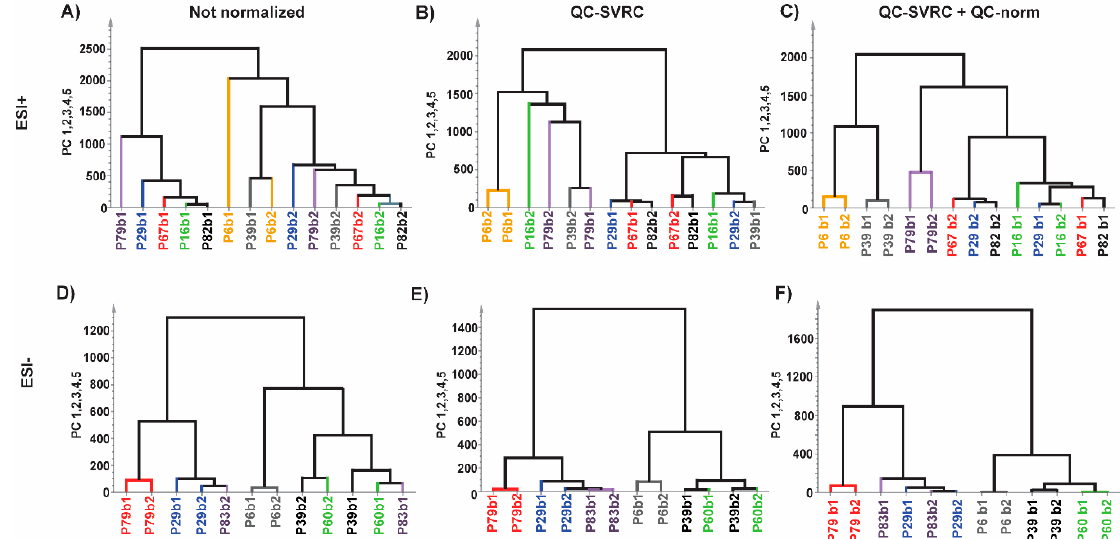
Figure 7. Normalization impact evaluated by HCA test on repeated experimental samples for ( A , D ) raw data; ( B , E ) after normalization by QC-SVRC and; ( C , F ) QC-SVRC + QC-norm for both, ESI + and ESI − modes, respectively. Legend . Every pair of samples represents one patient and is depicted in a di ff erent color for each polarity mode.